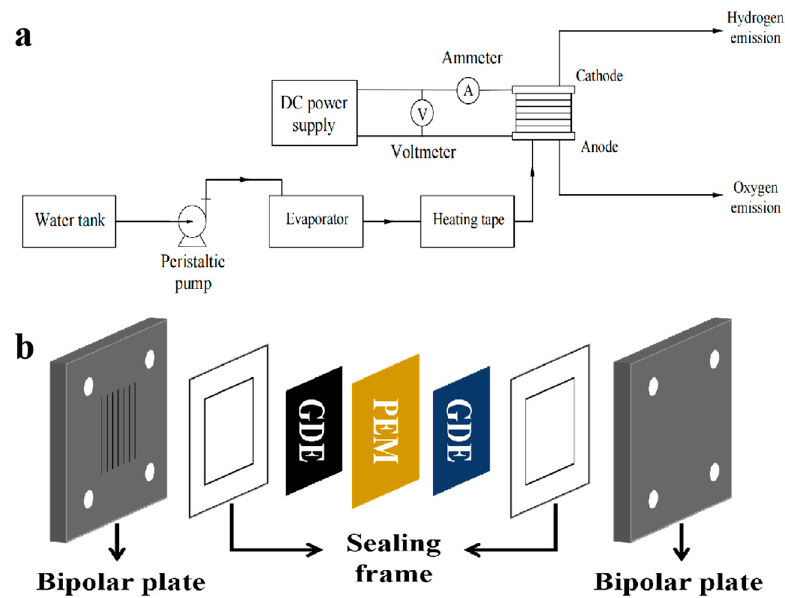
Figure 2. Schematic of ( a ) the HT − PEMWE setup and ( b ) cell structure.